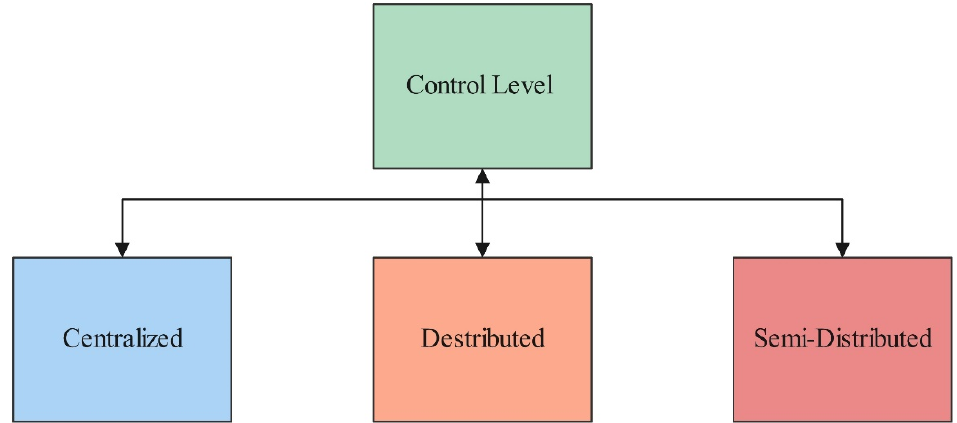
Figure 10. Control level of interference in D2D communication.